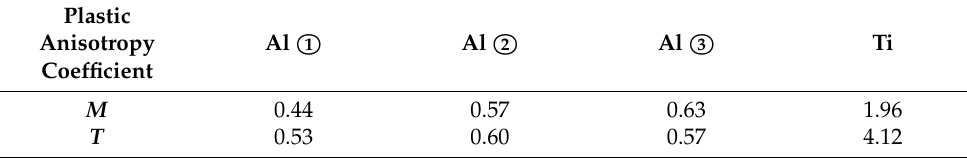
Table 1. Plastic anisotropy coefficients M and T of titanium and aluminum.